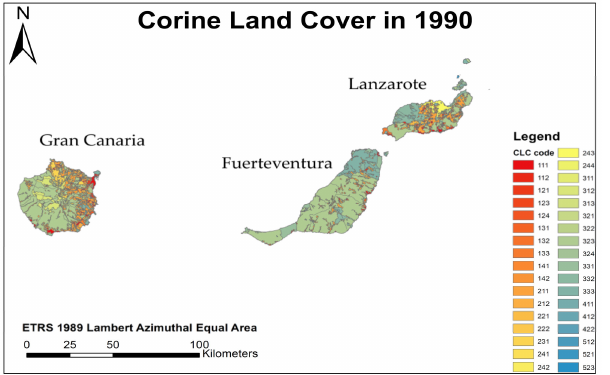
Figure A9. Thematic cartography regarding the land-use changes in the North of Canary Archipelago in the year 1990.